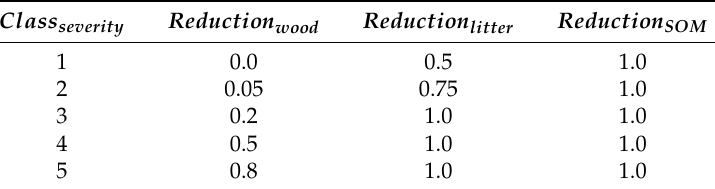
Table A13. Fire reduction parameters; inactive.